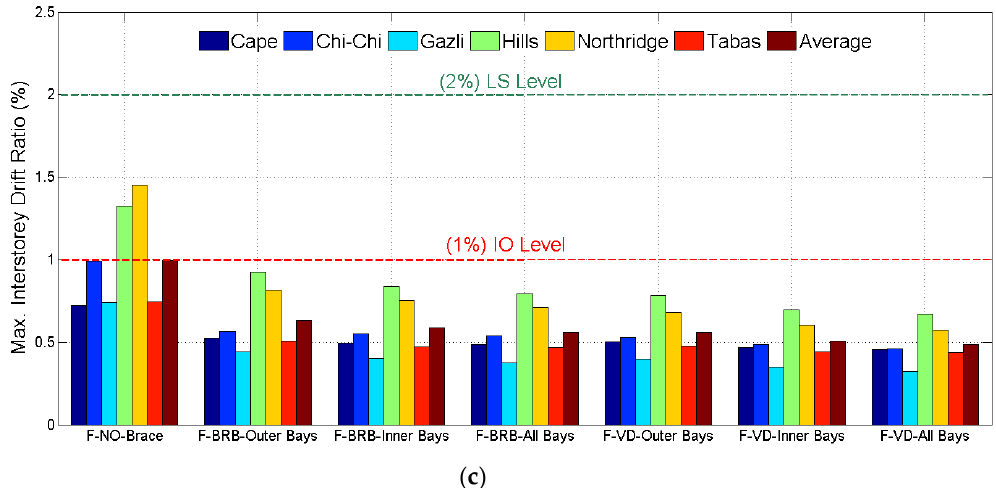
Figure 13. The maximum interstory drift ratio in ( a ) 4-, ( b ) 8-, and ( c ) 12-story frames.